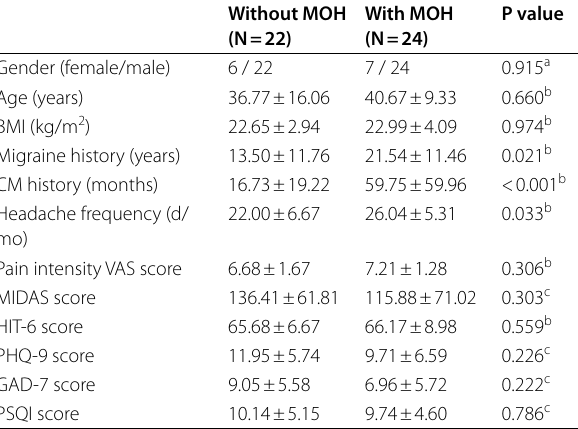
Table 2 Comparisons of demographics and clinical characteristics between CM with and without